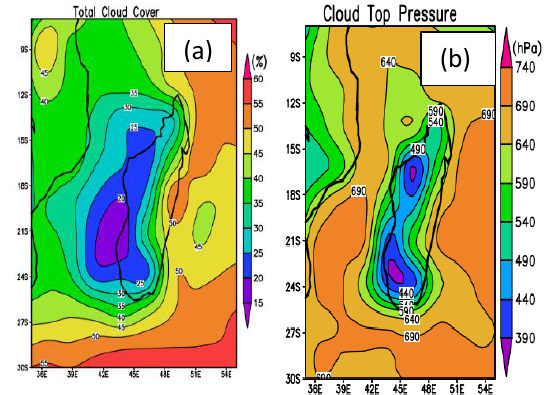
Figure 4. Nine-year (2008-2009) average (a) total cloud cover (%) and (b) cloud top pressure (hPa) during June to September months over the study region